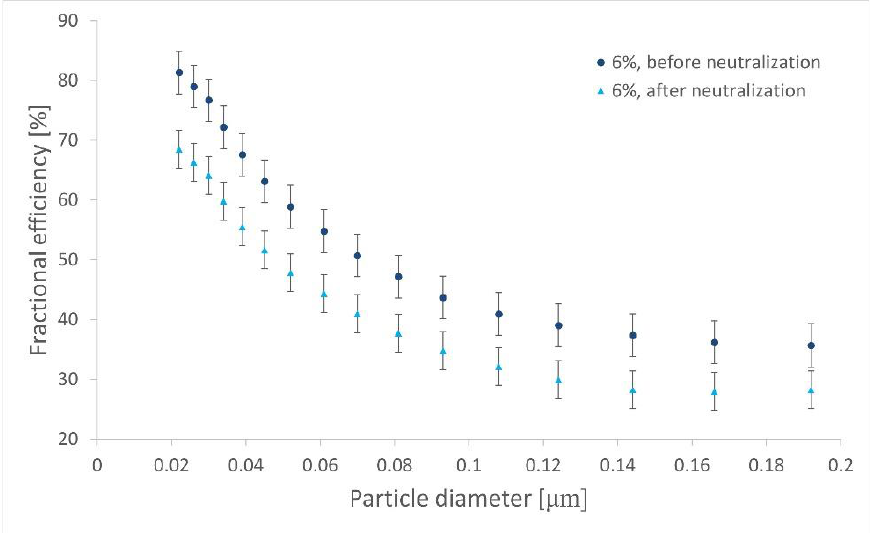
Figure 14. Fractional efficiency of material made from 6% solution, before and after neutralization.